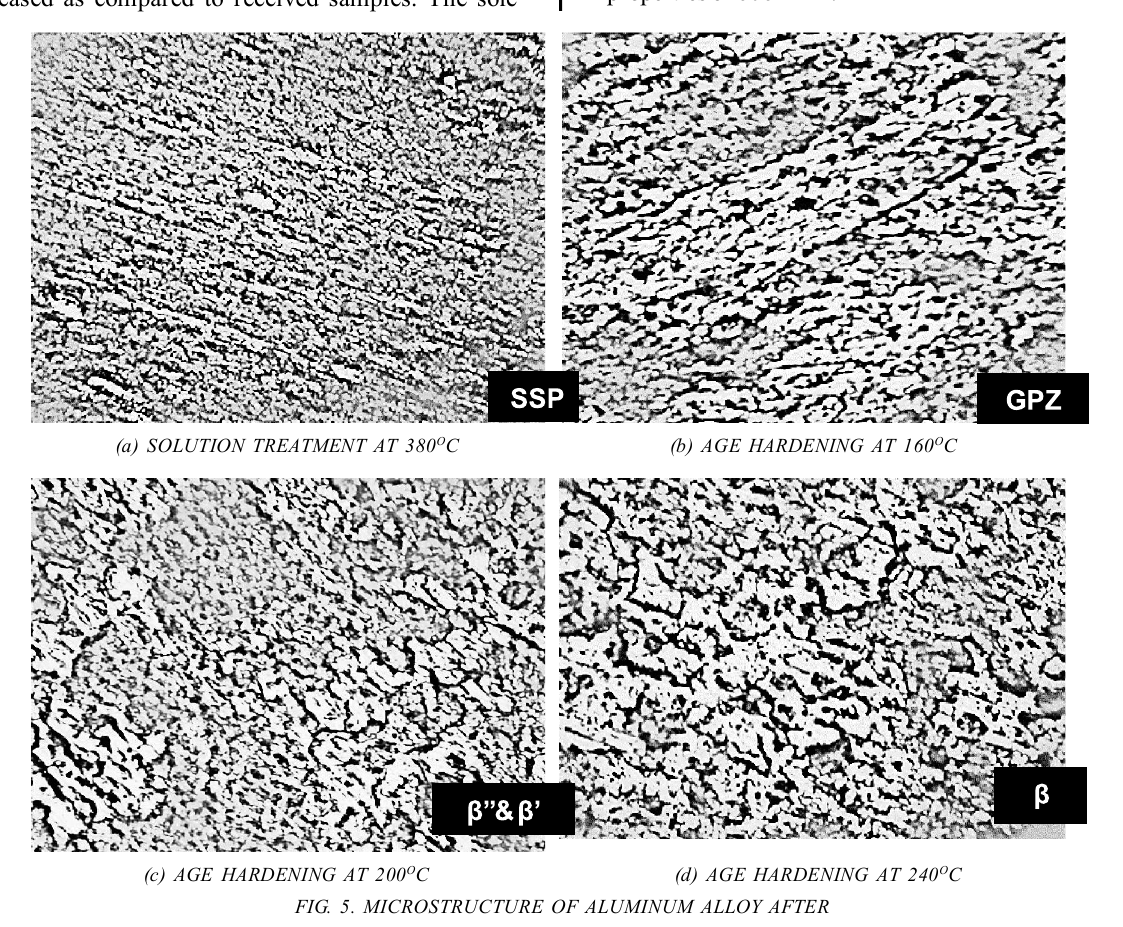
FIG. 5. MICROSTRUCTURE OF ALUMINUM ALLOY